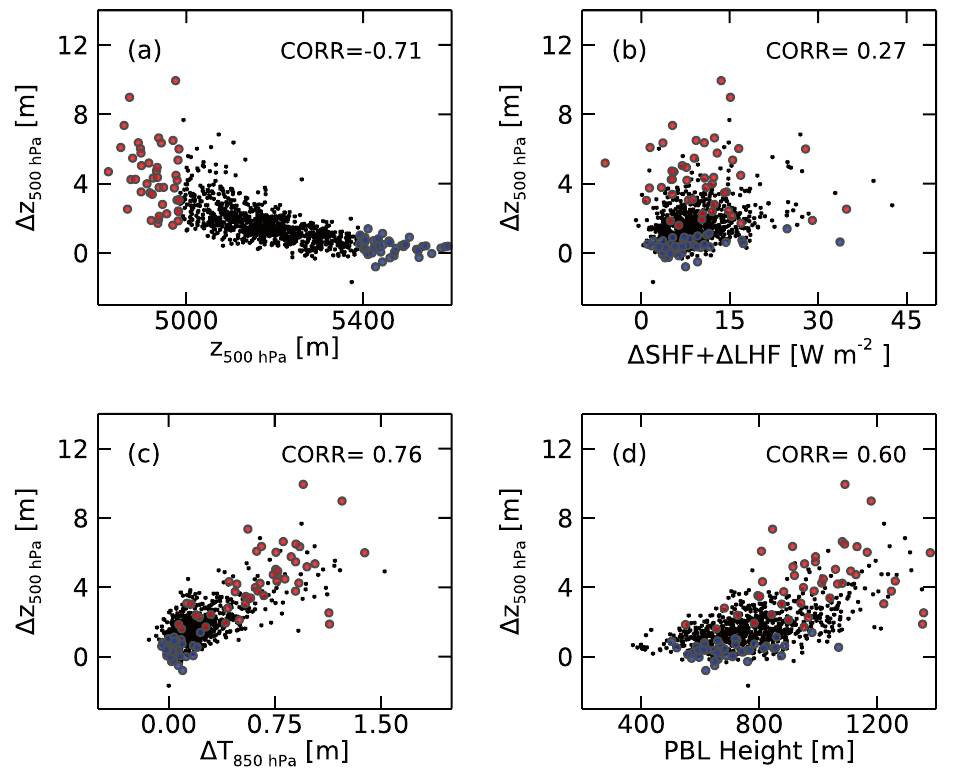
Figure 4. Dependency of the 500 hPa geopotential height response on ( a ) 500 hPa geopotential height, ( b ) responses of the sensible and latent heat fluxes at the surface, ( c ) 850 hPa air temperature response, and ( d ) planetary boundary layer height over the Barents Sea region (70–80°N, 15–75°E). All 903 realizations are plotted. Red and blue circles represent the low- and high-pressure cases,